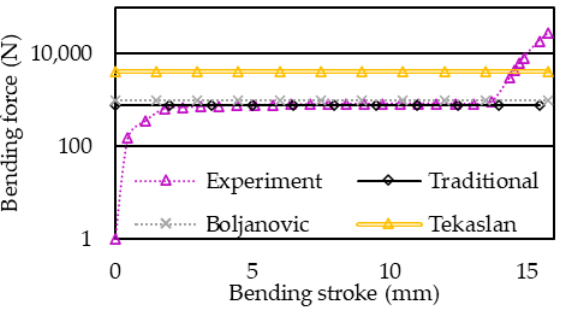
Figure 1. Comparison of the bending force obtained through experiments and calculated using formulas based on past research ( 𝑅 𝑝 = 3.5 mm, 𝑇 = 3.0 mm, 𝜃 = 120°, AA1100-O, 𝐿 = 70 mm, l k = 60 mm).